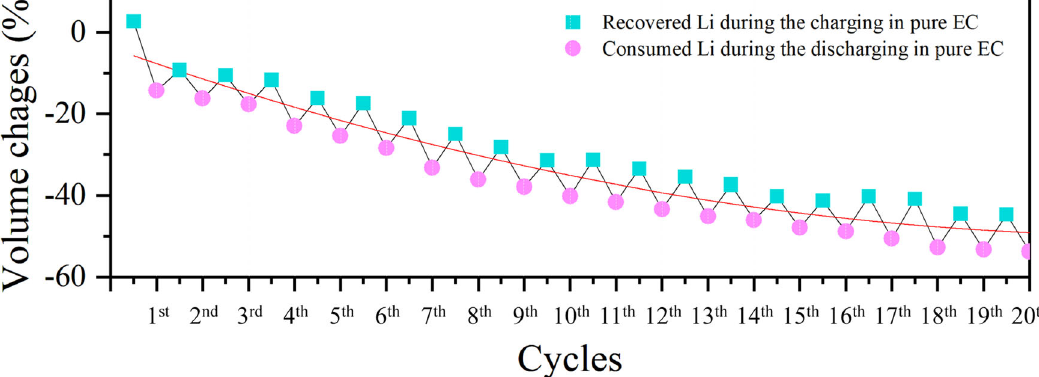
Fig. 4 Continuous large volume changes of lithium metal anode, resulting in relative anode volume loss and creating cracks in the SEI fi lm. A lithium metal anode represents a component with a charge of less than + 0.1.